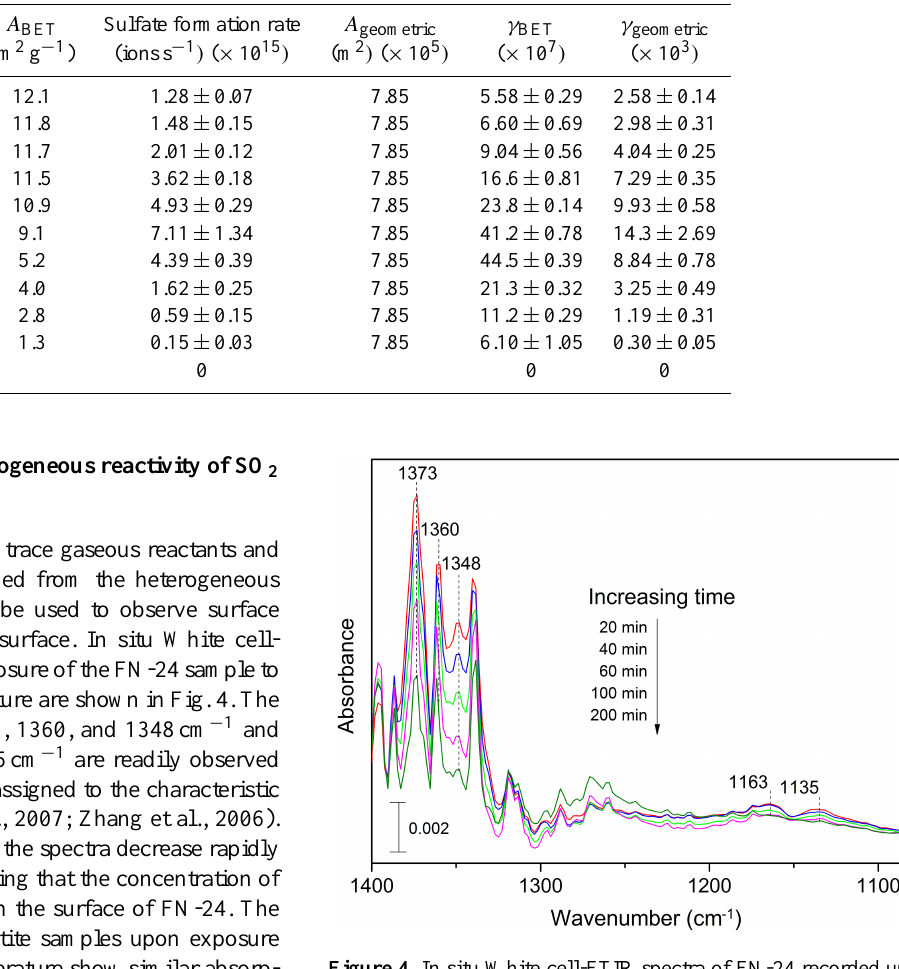
Figure 4. In situ White cell-FTIR spectra of FN-24 recorded upon exposure to 50ppm SO 2 + 21% O 2 at room temperature for differ- ent reaction